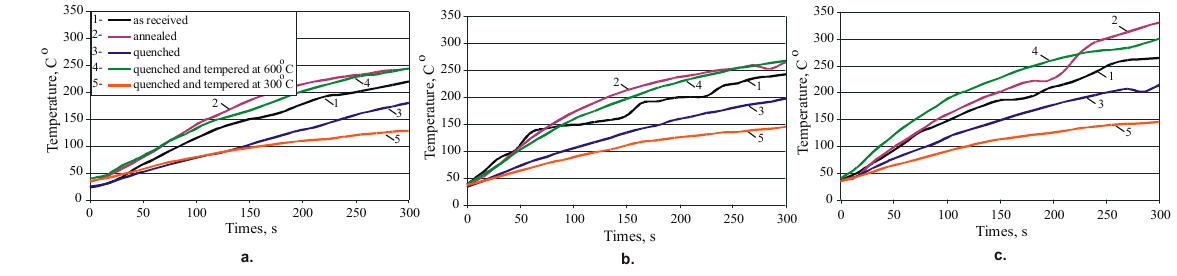
Figure 17. The contact temperature change: ( a ). 0–5min; ( b ). 5–10 min; ( c ). 10–15 min.